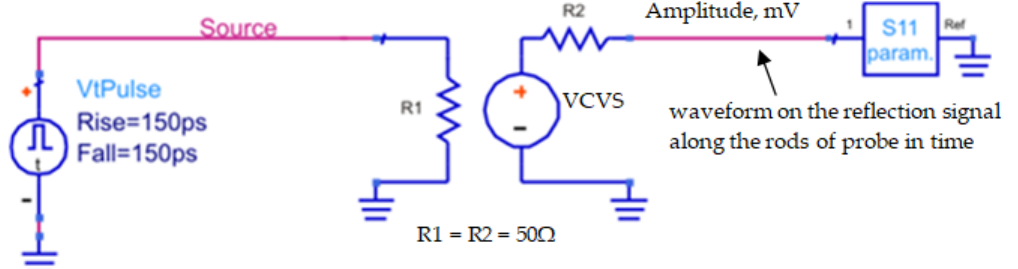
Figure 4. The scheme of the ADS transformation from the frequency domain to the time domain [31].